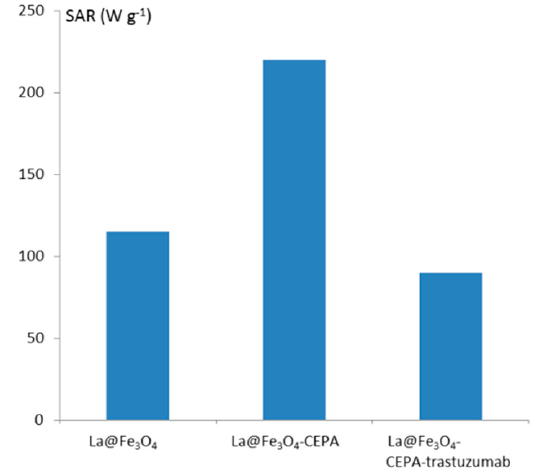
Figure 6. SAR values for unmodified and modified La@Fe 3 O 4 nanoparticles.